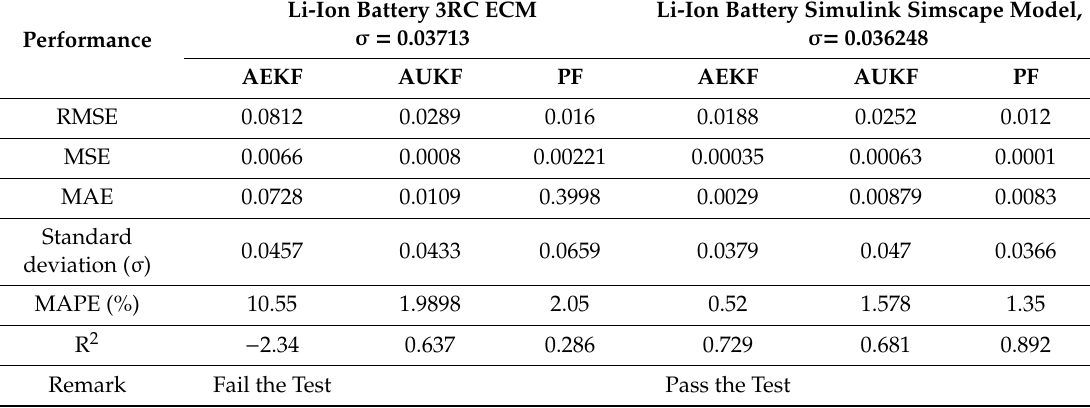
Table A3. Statistical errors—SOC estimates versus Li-ion battery Simscape model SOC values—Scenario R3: (SOCini = 0.4, σ noise = 0.01).